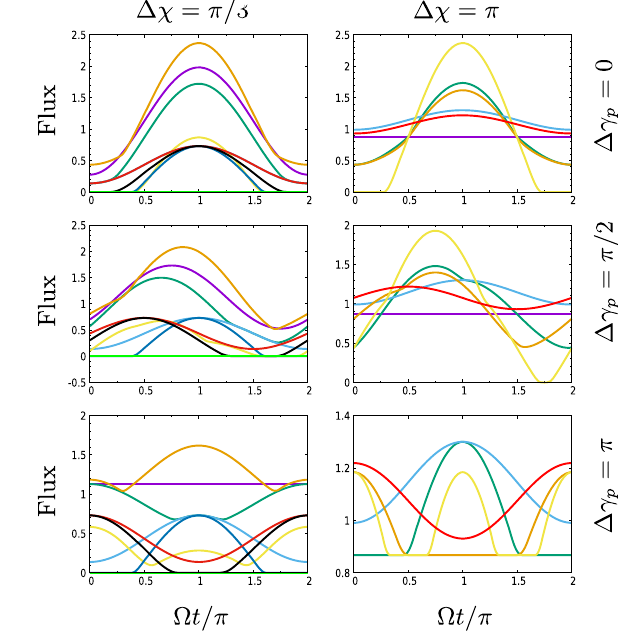
Fig. 23 Representative pulse profiles of each class. The violet, water green, light blue, orange, yellow, blue, red, black and green curves correspond respectively to classes I, II, III, IV, V, VI, VII, VIII and IX of Table 2